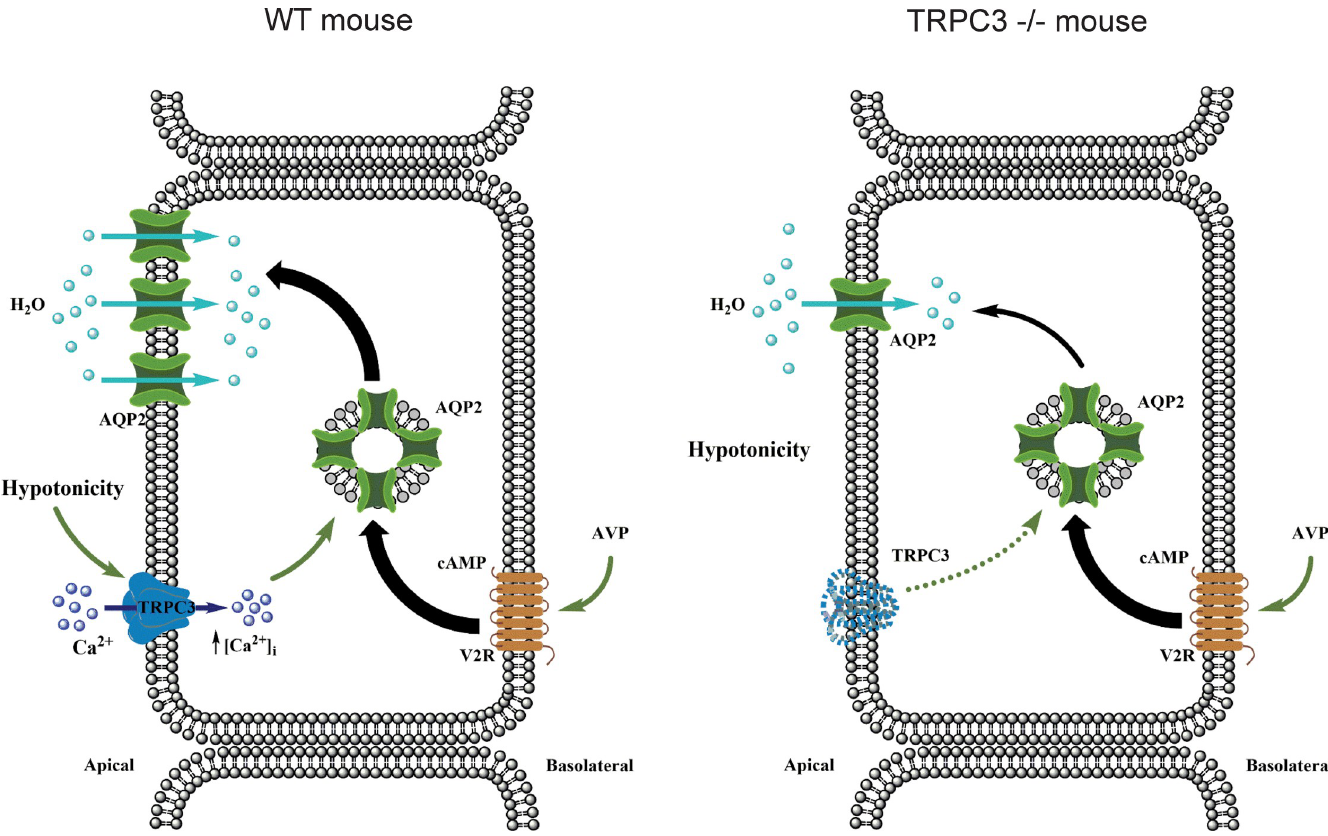
Fig 8. Principal scheme of osmosensitive TRPC3-dependent Ca 2+ influx into regulation of AQP2 mediated water transport in the CD. cAMP–cyclic adenosine monophosphate, V2R –type 2 vasopressin receptors, AVP–arginine vasopressin. TRPC3 deletion does not interfere with AVP-V2R induced AQP2 synthesis. In contrast, the lack of osmosensitive Ca 2+ flux via TRPC3 diminishes AQP2 trafficking to the apical plasma membrane in mutant mice.